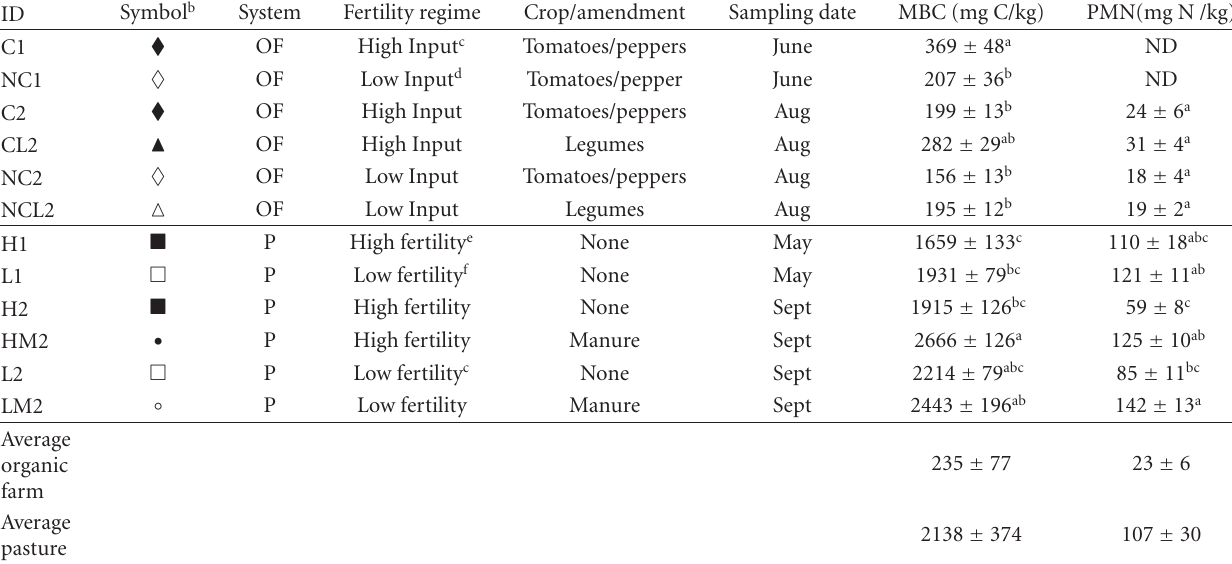
Table 1: Microbial biomass carbon (MBC) and potentially mineralizable nitrogen (PMN) in organic farm (OF) and pasture (P) soils a .